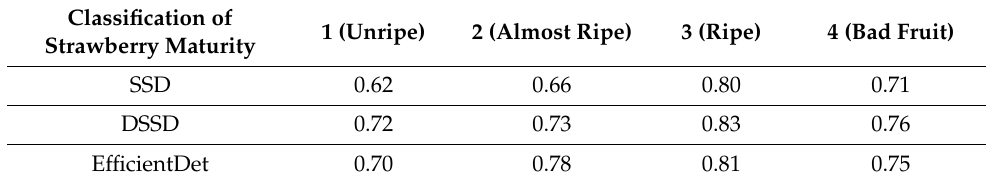
Table 6. Recognition accuracy results.